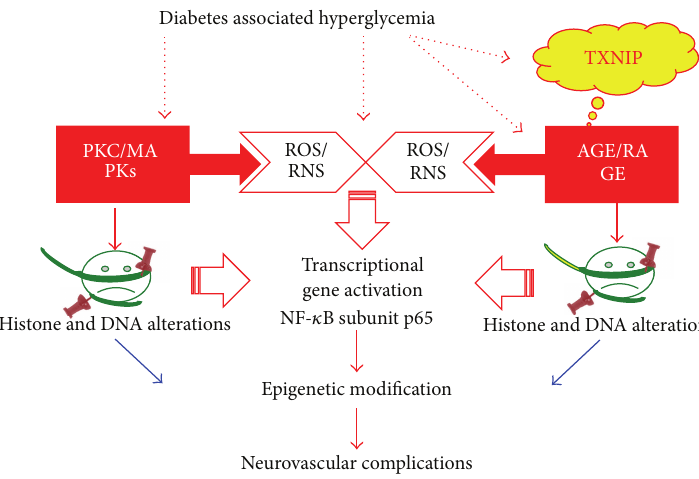
Figure 3: Hyperglycemia-induced pathways leading to epigenetic alteration. Schematic representation of hyperglycemia-induced epigenetic modifications. Hyperglycemia first enhances oxidative damage, which activates several pathways such as the hexosamine pathway, PKC, AGE/RAGE pathway. All these pathways contribute to the modifications of the histone code and activate the NF- 𝜅 B transcription factor. Moreover, they are inducing alterations in DNA methylation. These modifications lead to epigenetic alteration, which contribute to maintaining the metabolic memory, leading to neurovascular dysfunction in DR.